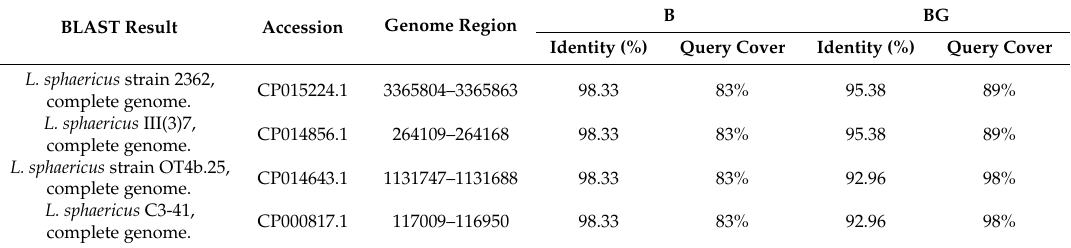
Table 3. Blastn results for the PCR